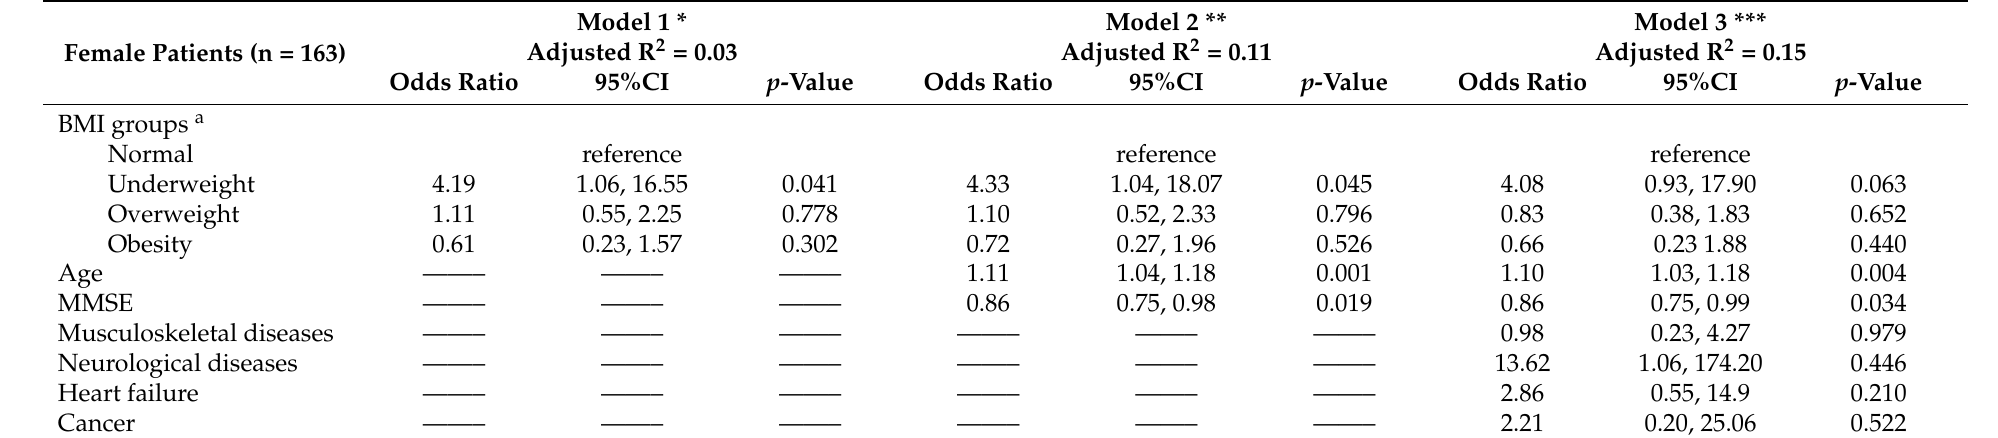
Table 3. Odds ratio in logistic regression model for frailty with normal weight as reference in female